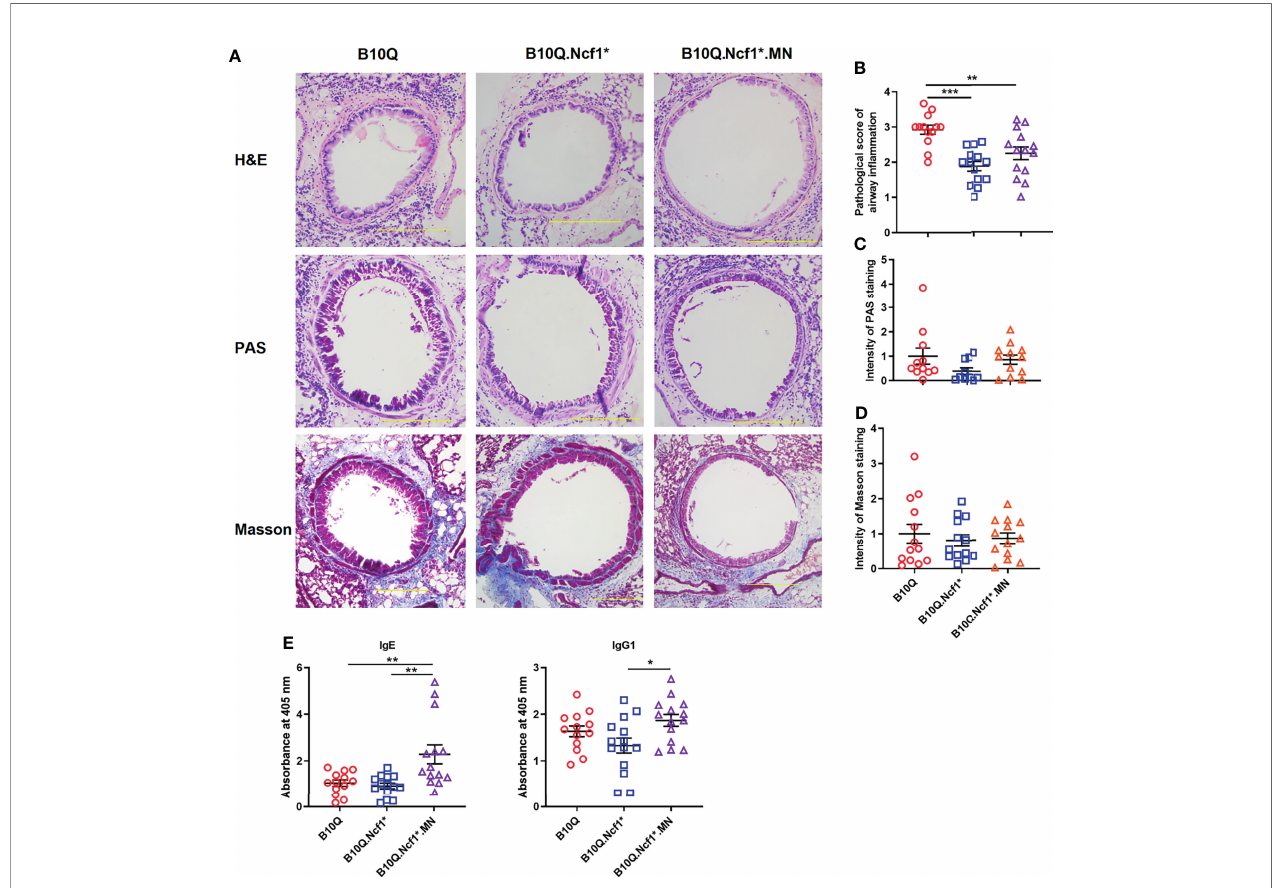
FIGURE 2 | Residential macrophage speci fi c Ncf1 contributes to the development of AIPI in mice. (A) Lung tissues of AIPI model induced in B10Q, B10Q. Ncf1 * and B10Q. Ncf1 *.MN mice were stained by H&E, PAS and Masson staining (n = 10-14 per group). Bar=200 m m. (B) Assess the degree of in fl ammatory in fi ltration around the airways. (C, D) Assess the airway mucus generation and the degree of airway fi brosis with Image Pro Plus software. (E) The concentrations of OVA-speci fi c IgE and IgG1 in serum were detected by ELISA, and the relative values are shown as the absorbance at 405 nm (n = 13-14 per group). All values are expressed as means ± SEM. * P < 0.05, ** P < 0.01 and *** P < 0.001, using one ‐ way ANOVA with post ‐ hoc comparison (Fisher ’ s)